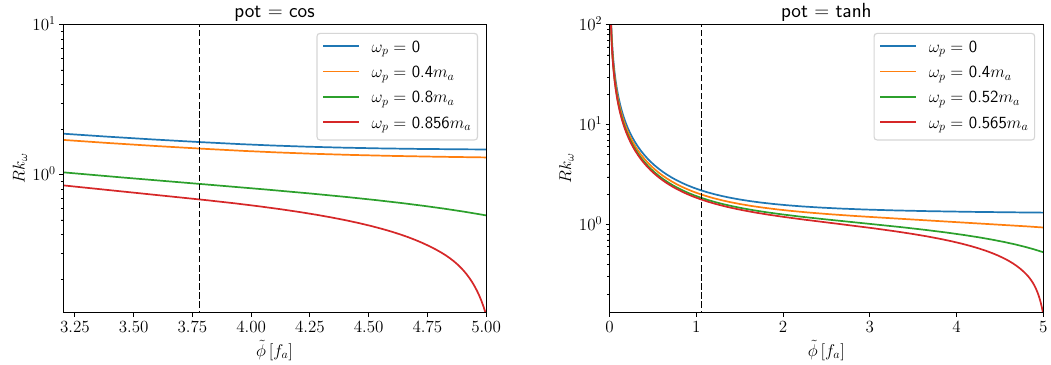
Figure 4 . The product Rk ω for a few values of the plasma frequency in the case of the two potentials considered. The vertical line represents the central amplitude at which ω = ω crit